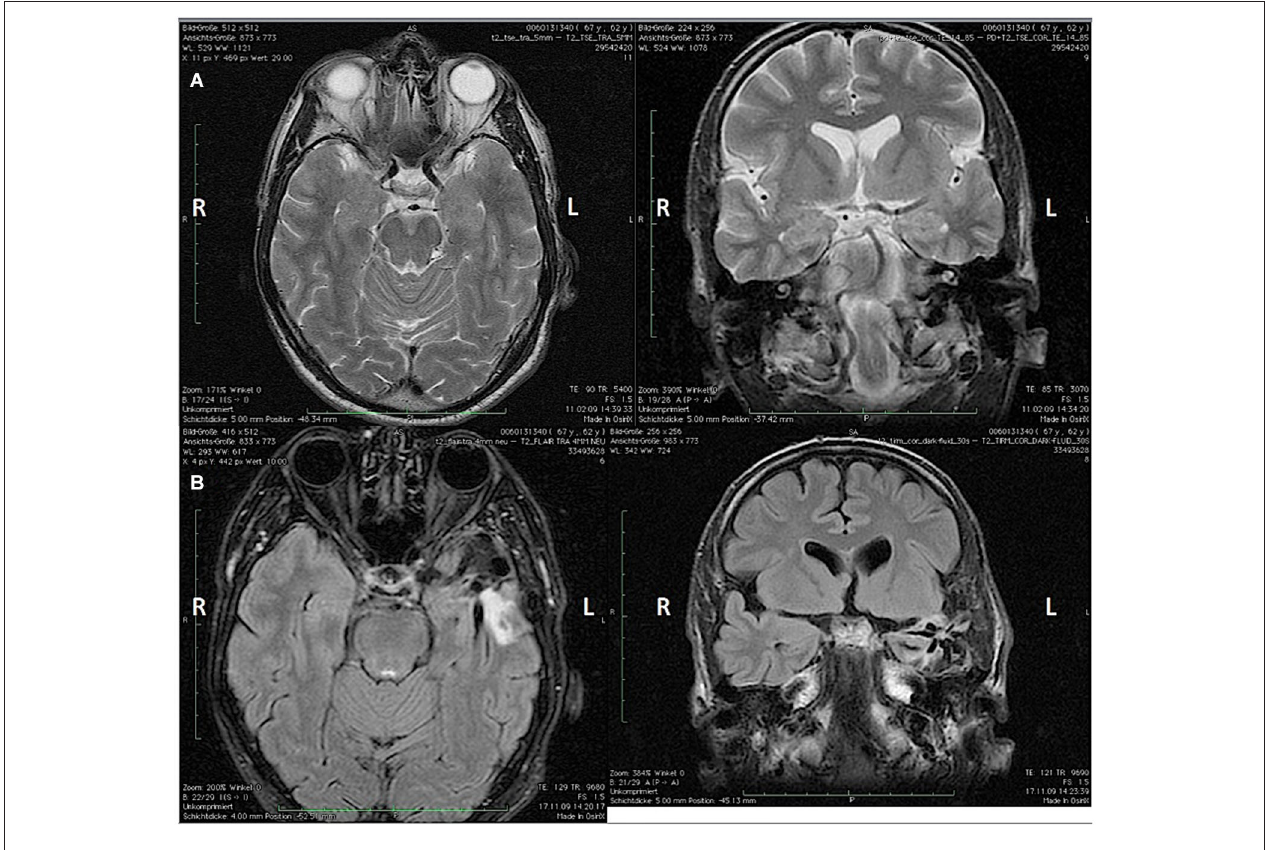
lobe resection and the shrinkage of the hippocampal remnant. L = Left hemisphere; R = Right